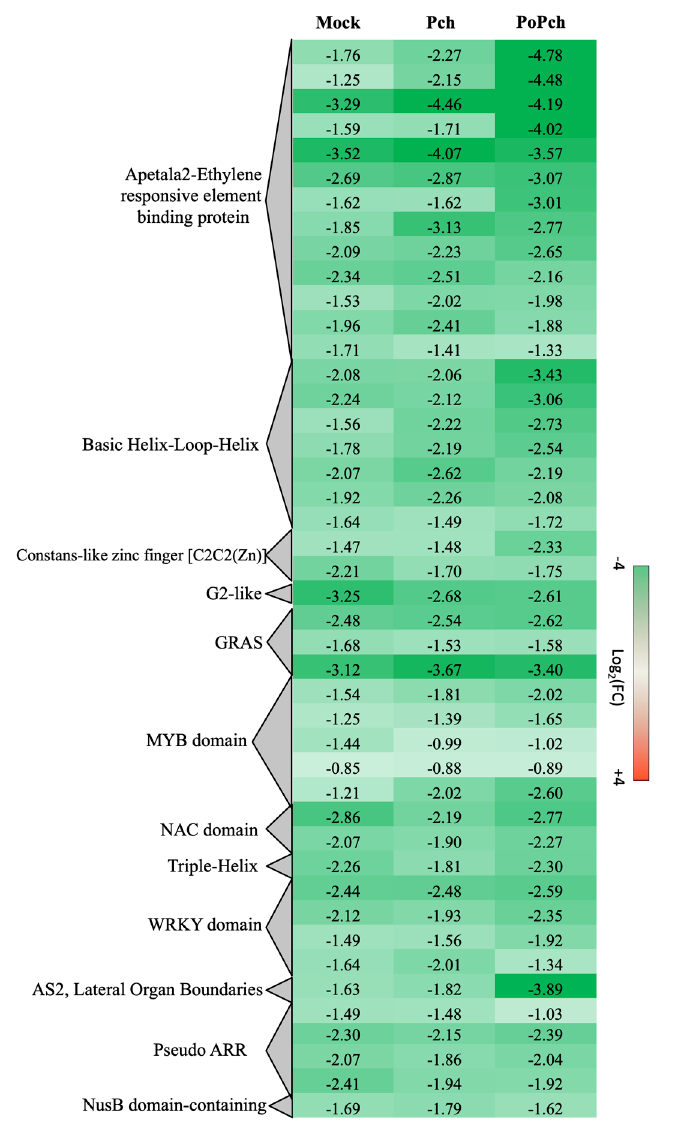
Figure 5. Global aspects of the grapevine transcriptome evolution for the transcription factor functional category between 0- and 14-dpi. Expression level values are given as a fold change on a log 2 basis. The red color means overexpression at 14-dpi and the green color means overexpression at 0-dpi. Mock: mock inoculation; Po: Pythium oligandrum ; Pch: Phaeomoniella chlamydospora ; PoPch: P. oligandrum and P.